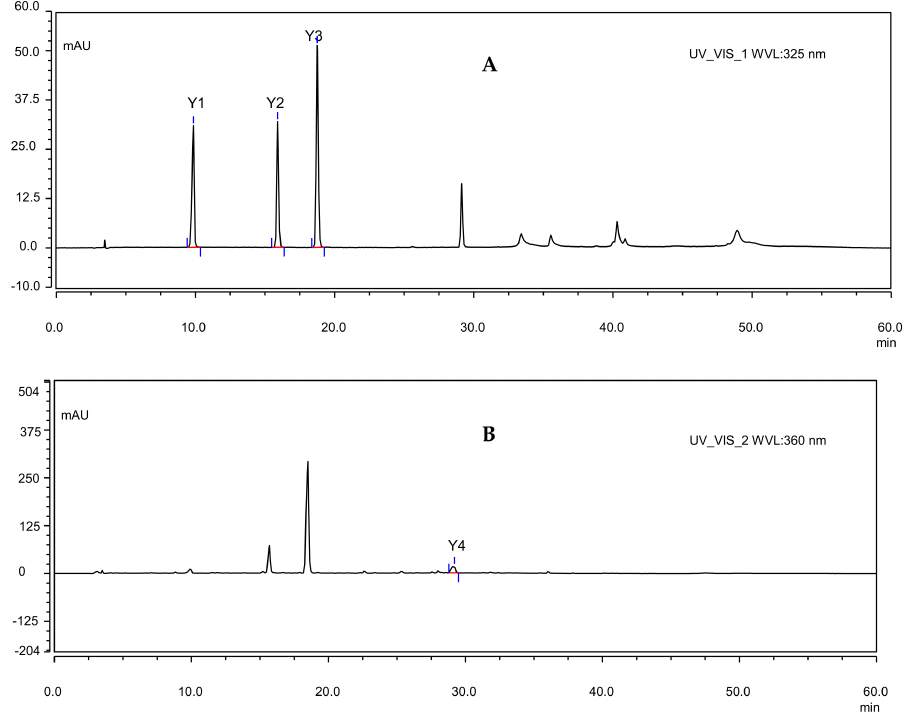
Figure 3. HPLC chromatograms of authentic standards and the methanol extract of P. vulgaris spicas. ( A , B ) UV chromatograms of the 4 authentic standards at 325 nm and 360 nm. ( C , D ) UV chromatograms of methanol extract at 325 nm and 360 nm. (1) caffeic acid (Y1); (2) salviaflaside (Y2); (3) rosmarinic acid (Y3); and (4) hyperoside